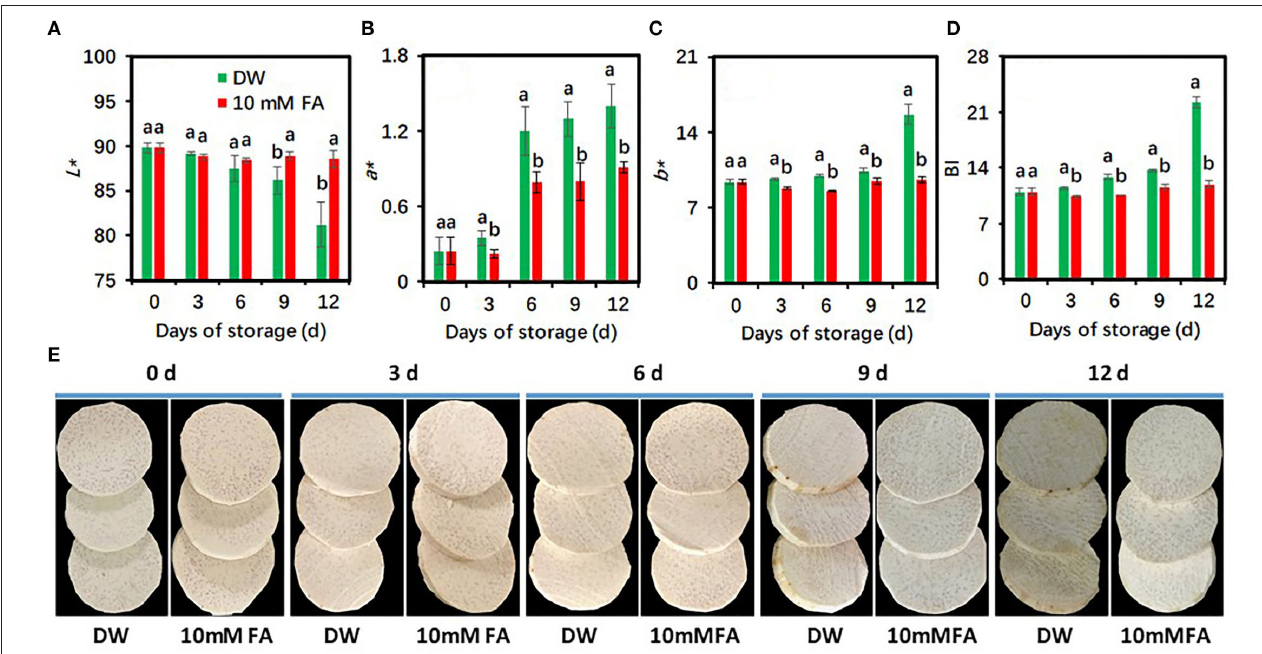
FIGURE 2 | Effects of 10mM FA treatment on the browning development of fresh-cut taro during storage at 5 ◦ C. (A) L * value; (B) a * value; (C) b * value; (D) browning index (BI), (E) the representative pictures of fresh-cut taros, which were taken at each sampling point. Each value is presented as means ± standard deviation (SD, n = 3). Statistical differences ( p ≤ 0.05) between the control and 10mM FA treatment at the same time point are analyzed and indicated using different letters above the